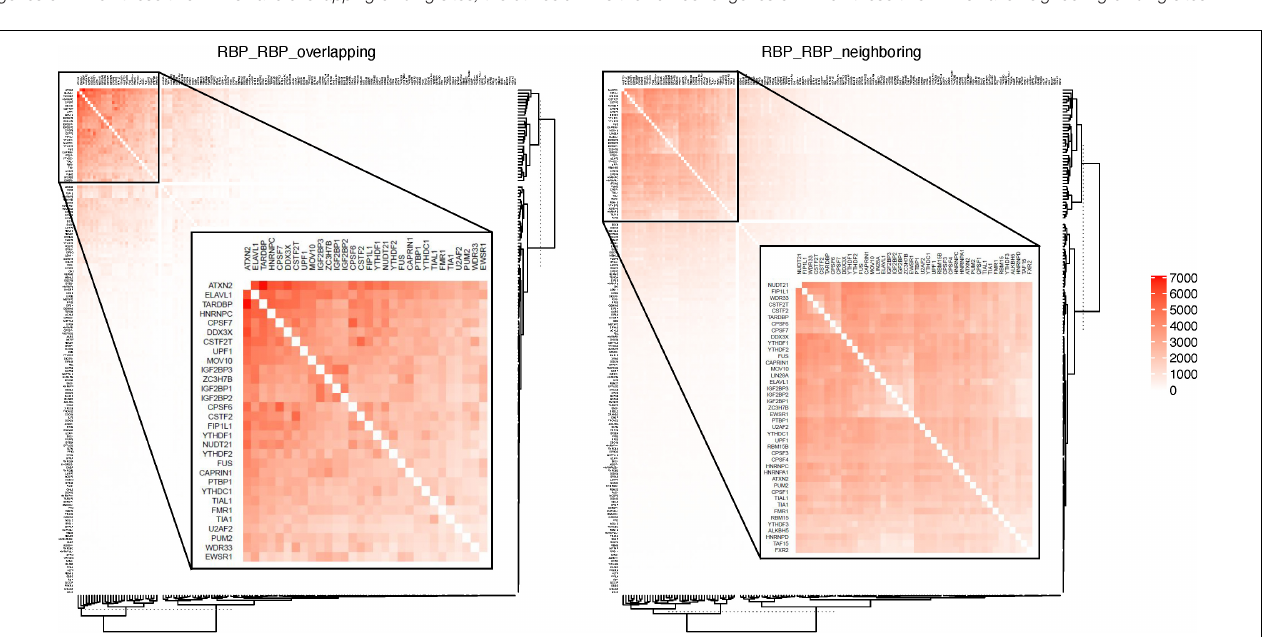
Number of target genes with neighboring binding sites